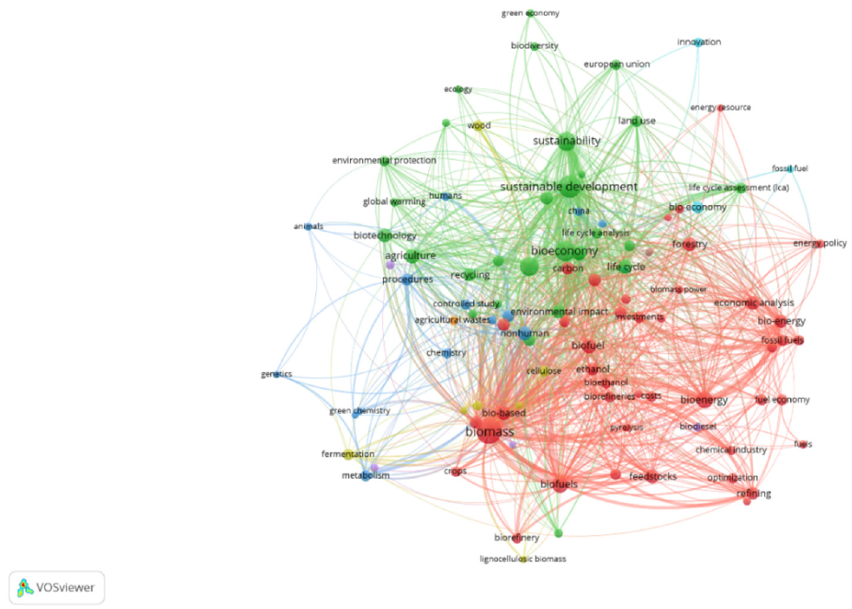
Figure 1. The top 100 keywords with the strongest links in Scopus related to bioeconomy.